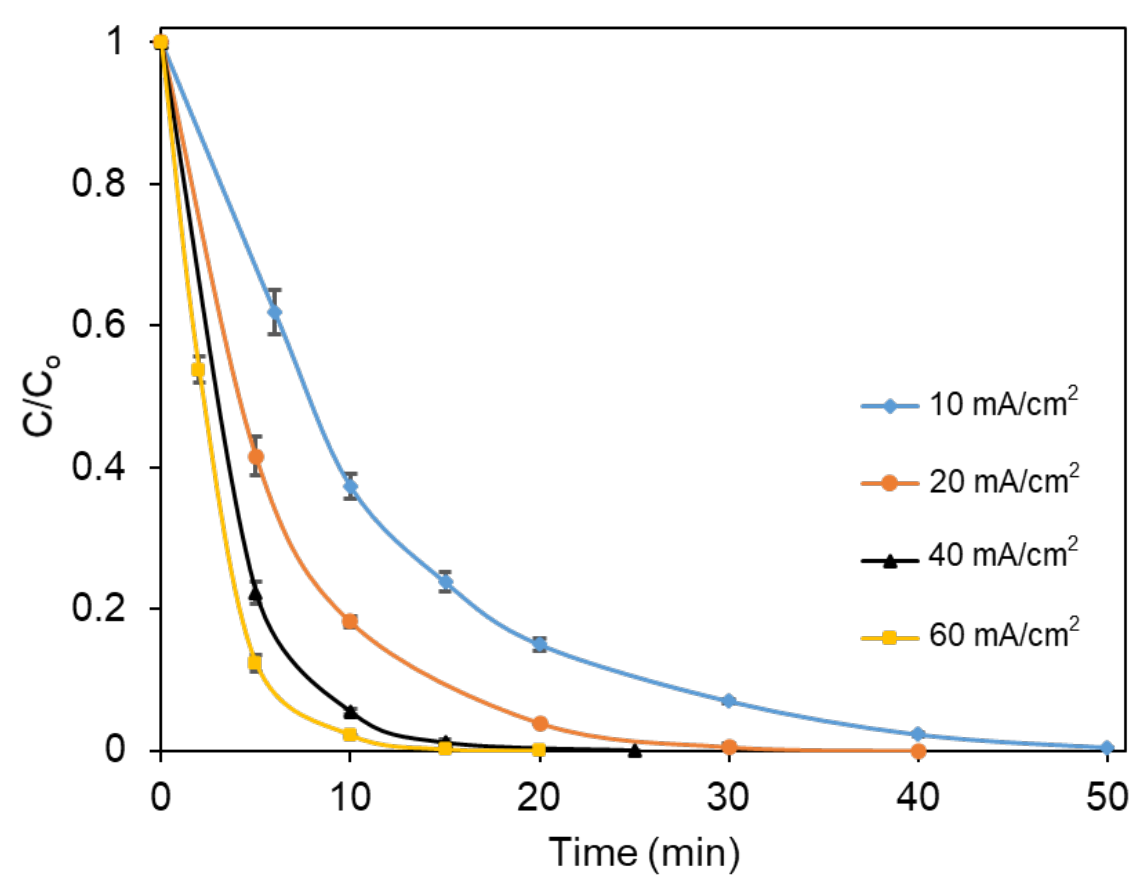
Figure 4. Kinetics of degradation of MB (50 mg/L) in 0.17 M Na 2 SO 4 aqueous electrolyte containing 2 g/L NaCl at various current densities.